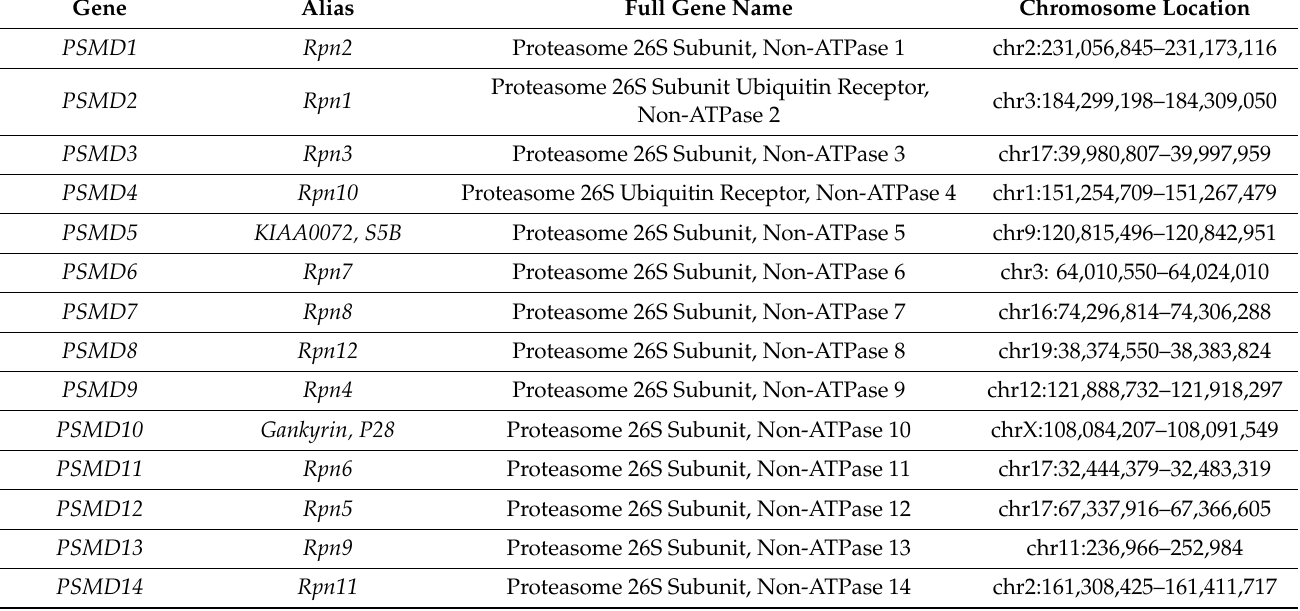
Table 1. Non-ATPase subunits of the 19S proteasome